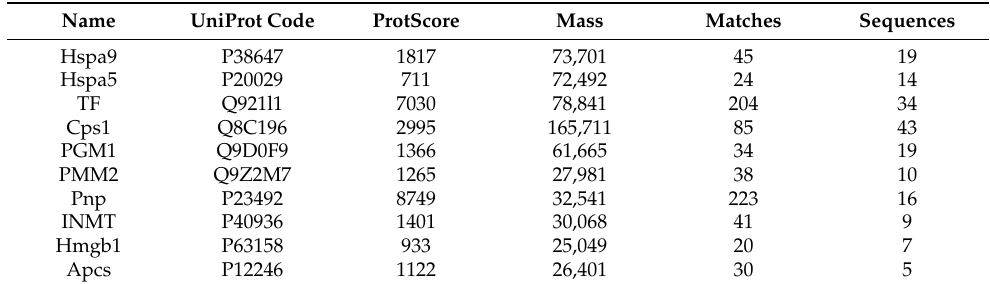
Table 2. Summary of the identity and related information of the differentially expressed proteins between control and CSDS